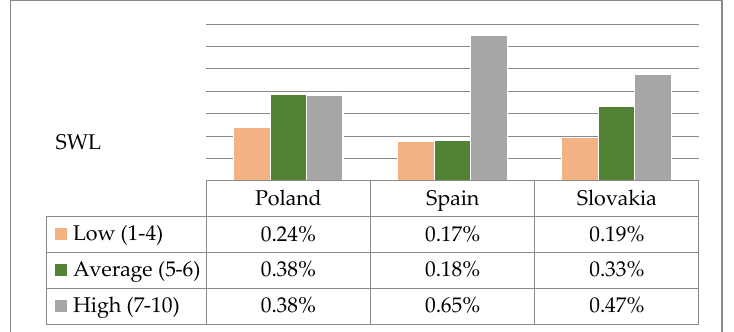
Figure 4. Structure of results of life satisfaction according to SWLS on the sten scale among Polish, Spanish and Slovak students.